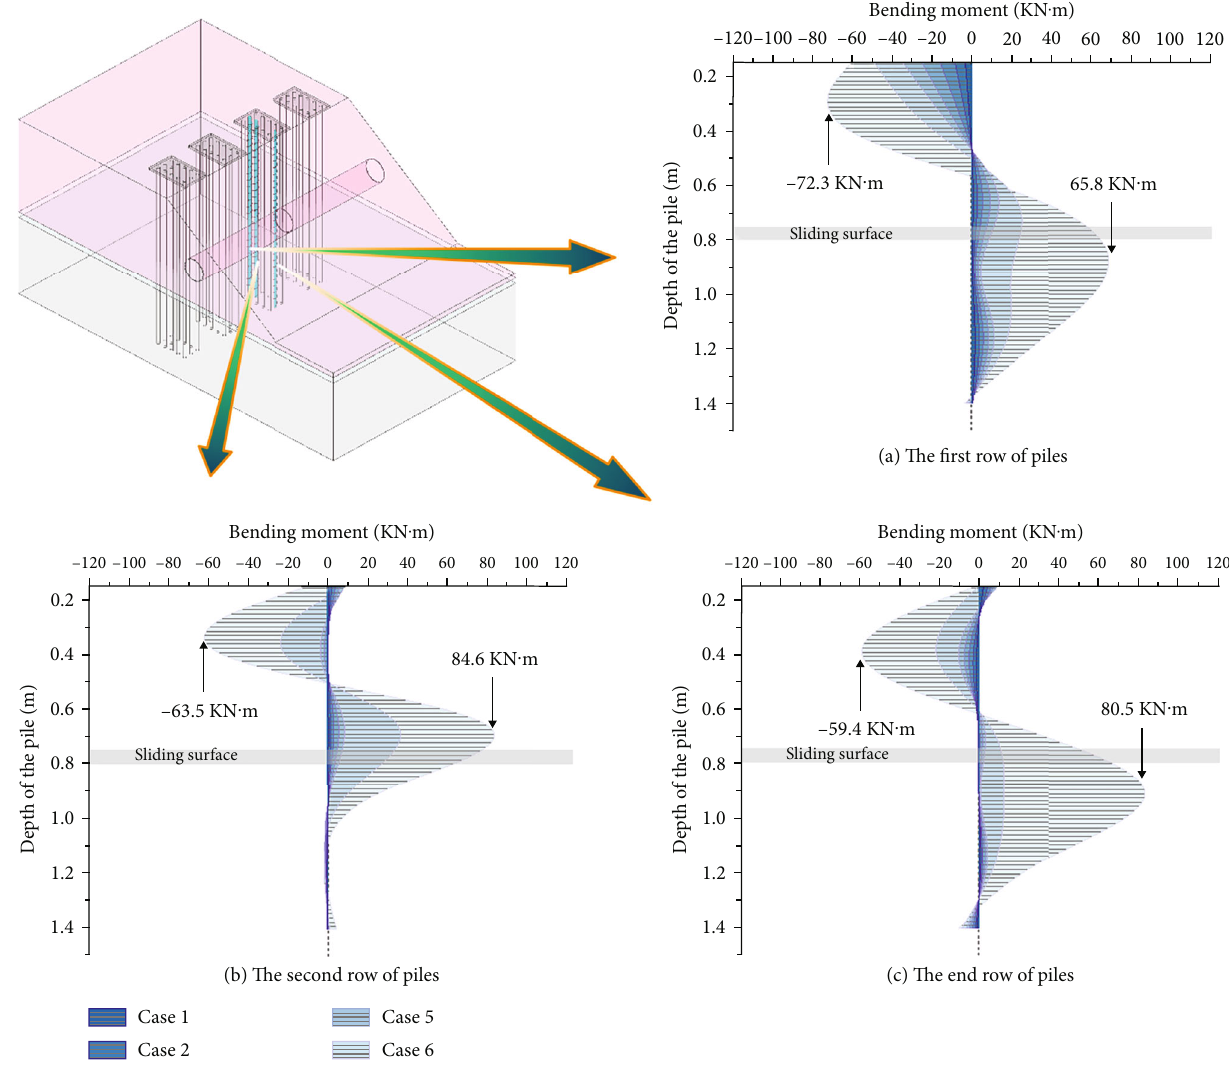
Figure 12: Bending moment distribution of screw